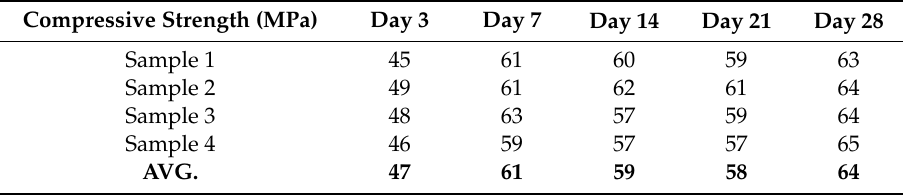
Table 2. Compressive strength results for the alkali-activated (AA) cubic samples.